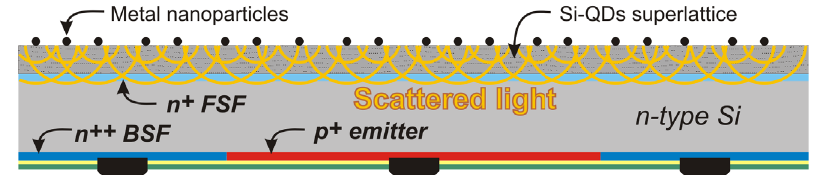
Fig. 6. The LIMA cell: enhancing Si cell light interaction using plasmonic techniques coupled with quantum dot